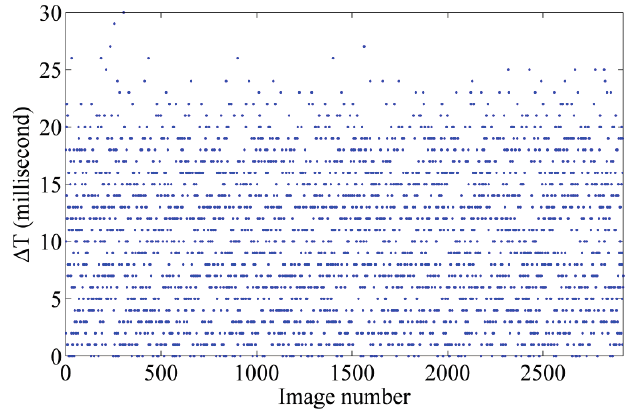
Figure 17. Results of the time-synchronization test.